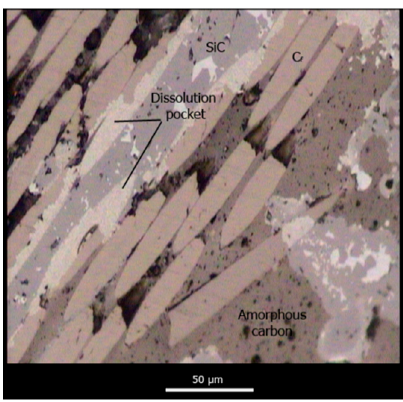
Figure 14. C f /SiC and C f /C interfaces in C f /SiC composite materials. Figure 14. C f / SiC and C f / C interfaces in C f / SiC composite materials.